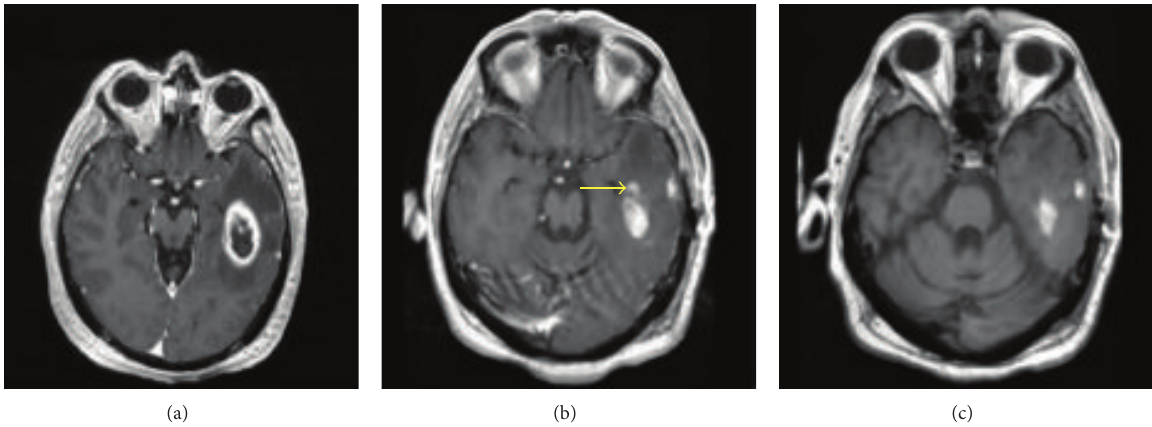
Figure 1: Preoperative and postoperative images. (a) Preresection T1 axial MRI with contrast showing a temporal lesion with an estimated 5.0 cubic centimeter volume. (b) Immediate postresection T1 axial MRI with contrast showing a slight amount of residual enhancement at the anteromedial margin of the resection cavity. (Yellow arrow indicates residual tumor area not present in (c)). (c) The corresponding noncontrast enhanced T1 MRI image taken at the same time demonstrates that the posteromedial and lateral hyperintensities are in fact blood products and postoperative change rather than gross residual tumor. A 93.3% volumetric resection was achieved.